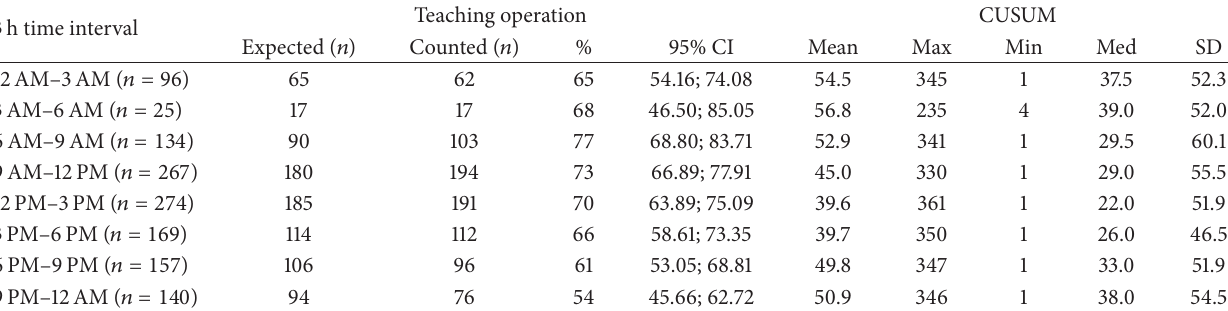
Figure 1: (a) Shown is the distribution of night- and daytime shifts over 24 hours at our institution. Regular working hours at our institution are 07:30 AM to 4:30 PM. Included are two hand-over periods of 30–45 minutes for each shift change (light blue sectors) . Only in cases of high urgent emergencies (e.g., bowl perforations, intraabdominal bleeding, and polytrauma situations) would surgery be started within those intervals. If arrival of an upcoming kidney transplantation is scheduled after 6AM, the transplantation is usually planned to start with the day shift team after 7:30 AM. (b) This circle with the increasing dyeing of the sectors symbolizes the increasing levels of exhaustion that can be caused by sleep deprivation and a continuous workload over the course of a 24-hour shift. Table 2: Proportions of teaching operations and distribution of the cumulative sum (CUSUM) of the 1st surgeons’ kidney transplantations over the 3 h time intervals. Shown are the distribution of teaching operations and the distribution of the cumulative sum (CUSUM) of the 1st surgeons’ kidney transplantations over the 3 h time intervals. There was no significant difference in distribution of CUSUM between the 3- hour intervals (Levene’s test, 𝑝 = 0.627 ) (Supplemental Figure b). The proportion of teaching operations was unequally distributed between the9 PMand12 AMtimeintervalandthetwotimeintervalsof6 AM–9 AMand9 AM–12 PM,withasignificanthigherproportionofteaching operations during the morning shift hours between 6 AM and 12 PM (Chi 2 test 𝑝 < 0.05 ) (Supplemental Figure a). The proportion of teaching operations within the 3 AM–6 AM interval was not significantly different compared to all other 3-hour intervals (Chi 2 test 𝑝 > 0.05